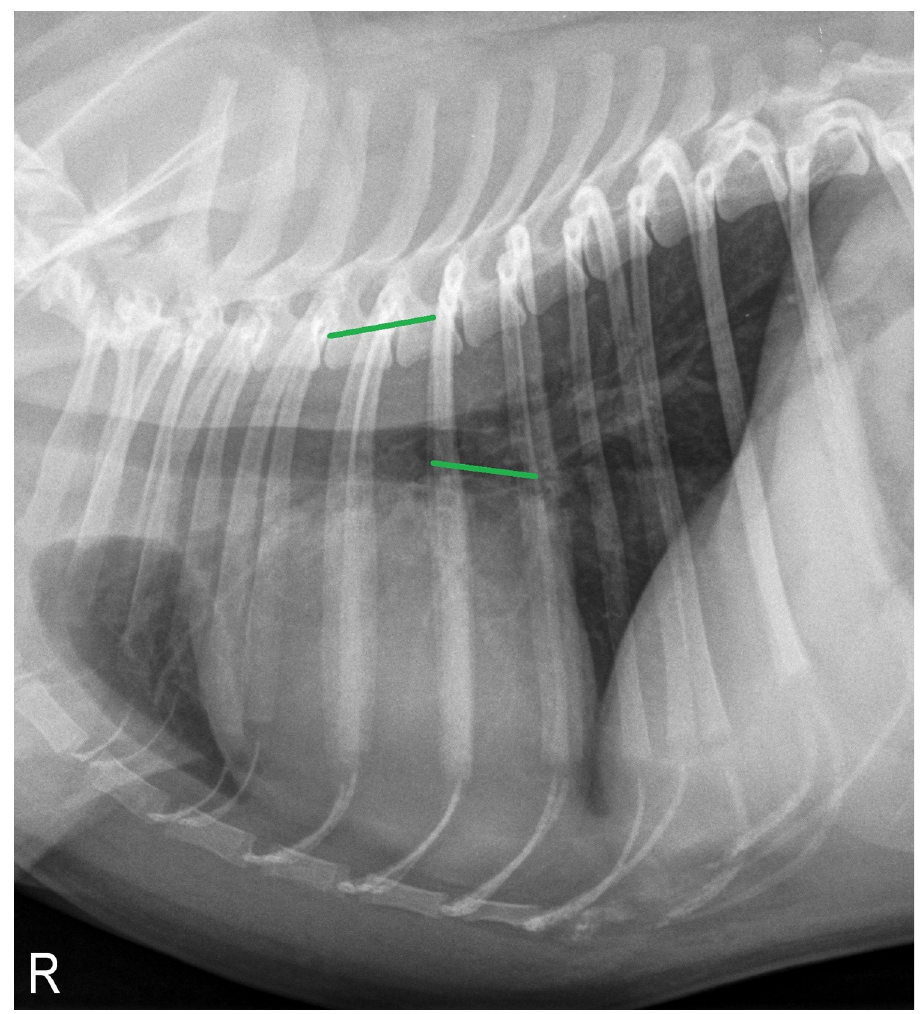
Fig 2. Right lateral thoracic radiograph of the same two-year-old male pug as in Fig 1, depicting the method for determining vertebral left atrial size (VLAS). In this case, VLAS turned out to be 1.6v.